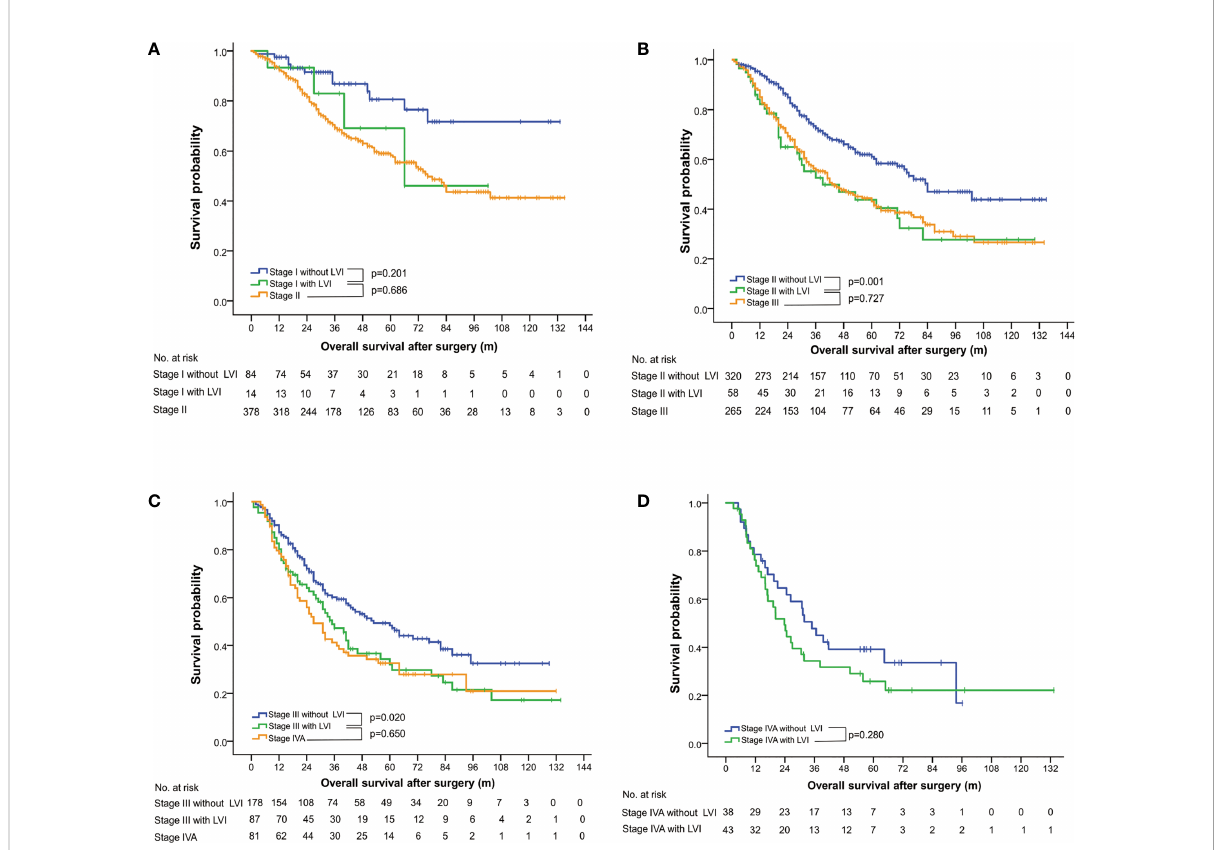
FIGURE 1 Overall survival curves strati fi ed by status of lymphovascular invasion and pathological stages, based on the 8th edition of the AJCC TNM classi fi cation system for esophageal squamous cell carcinoma. LVI, lymphovascular